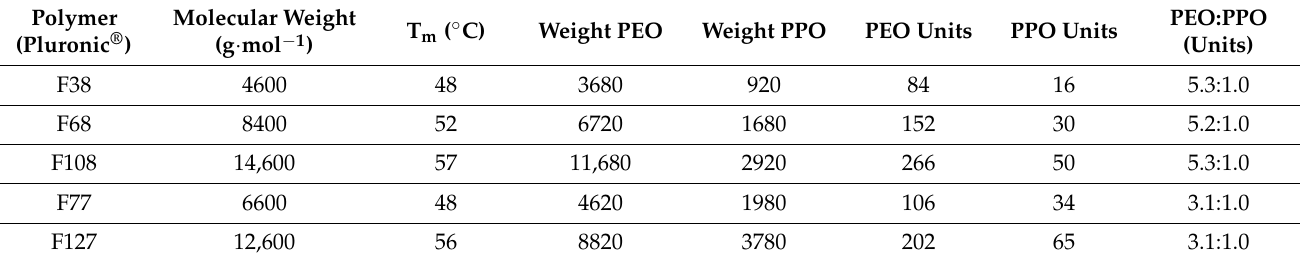
Table 1. Properties of PEO-PPO-PEO block copolymers.